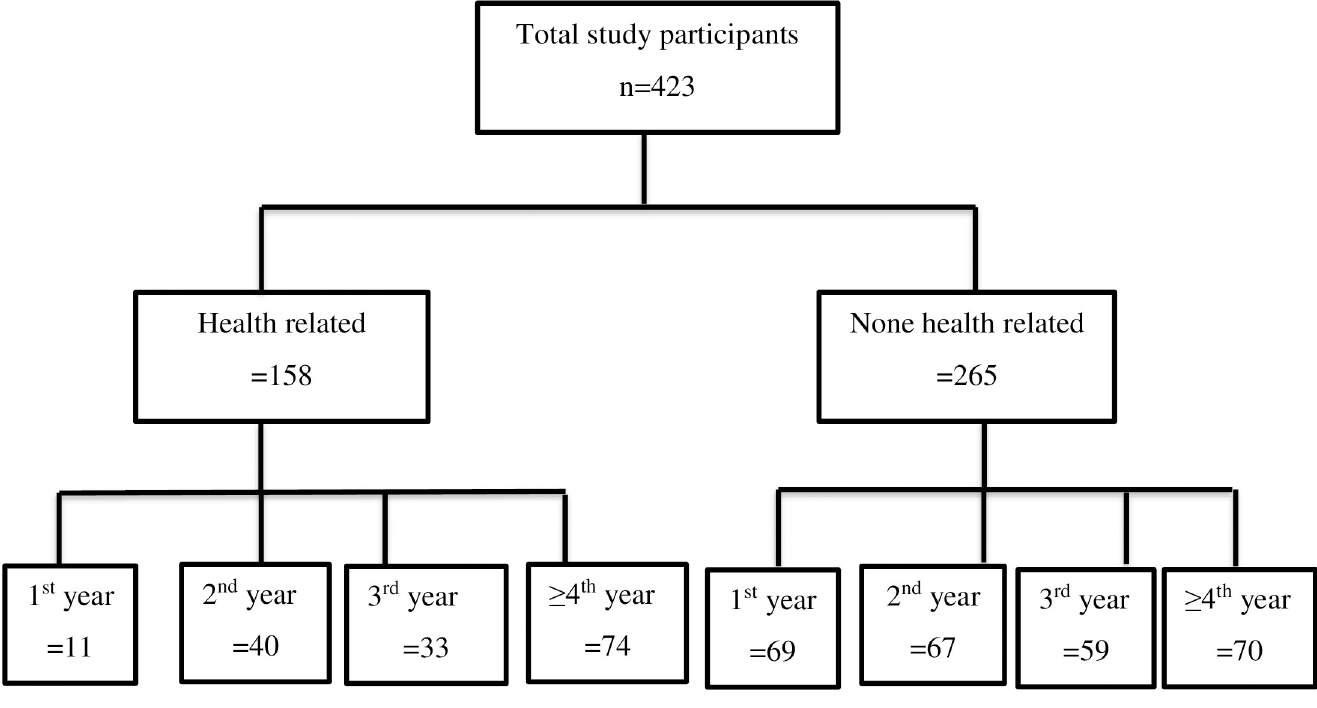
Fig 1. Flowchart of study